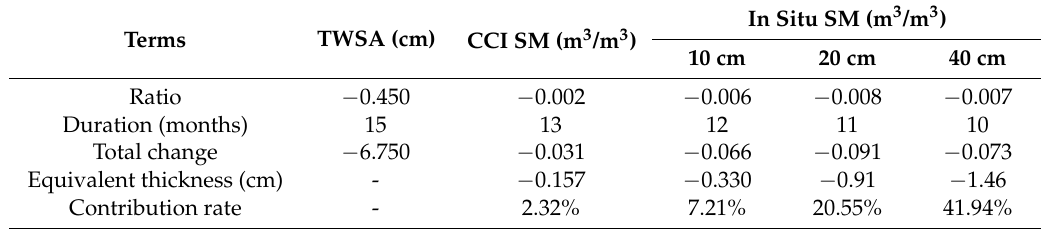
Table 1. Contributions of Soil Moisture Anomalies (SMA) to